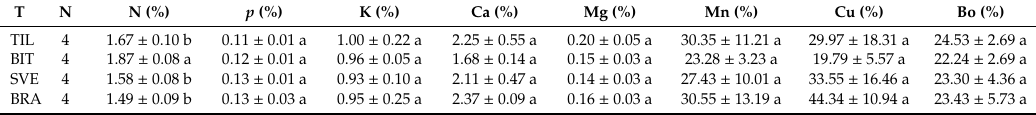
Table 5. Leaf nutrient average content and standard deviation for the di ff erent treatments in